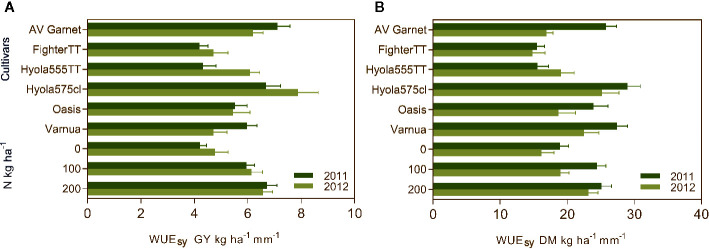
Water use efficiency grain yield (WUESY) (A) and WUE dry matter (WUEDM) (B) of different cultivars under N rates of 0 kg N ha−1, 100 kg N ha−1, and 200 kg N ha−1 during the growing season of 2011 and 2012. Values are presented as mean of replications for cultivars and N treatments as cultivar × N treatment interactions for WUEGY and WUEDM were absent during both years.